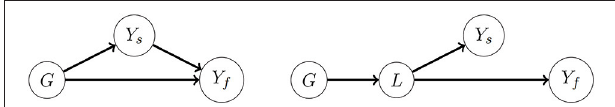
FIGURE 1 | Causal diagrams showing different assumptions about the mechanisms underlying genetic correlations between a high-dimensional secondary phenotype Y s and a target (focal) trait Y f . For ease of presentation, Y s is represented by a single node; causal relationships among some of the secondary traits might exist. Outgoing arrows from the node G to a trait Y f represents represent the genetic effect of all loci combined. The arrow Y s → a causal effect from at least one of the secondary traits on the target trait. (Left) Some of the genetic correlations between Y s and Y f are the result of the Y f ; to some extent they may also be a consequence from causal effect Y s → Y f and G Y s (see Kruijer correlation between the direct genetic effects G → → et al., 2020 for more mathematical details). (Right) There is no causal effect Y s Y f , and genetic correlations between them may be induced by genetic → effects on a latent trait L that is affecting both Y s and Y f . The LS-BLUP and RF-BLUP methods assume the left diagram, and reduce the dimension of Y s first making a prediction ˆ Y f using Y s within the training set. Also the GM-BLUP method implicitly assumes the left